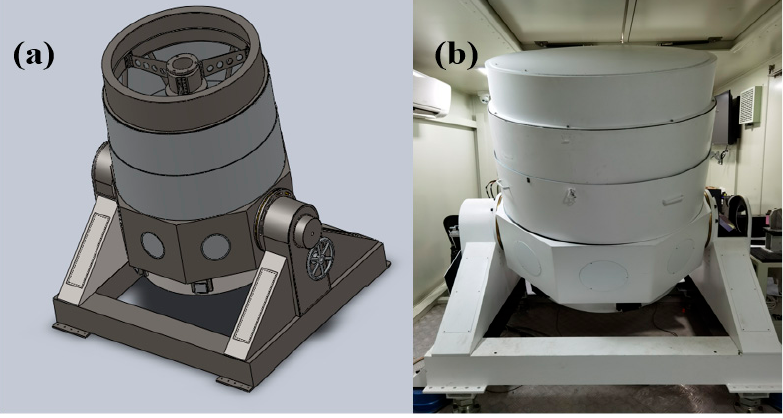
Figure 13. The structural of the upgraded 800 mm Cassegrain telescope. ( a ) Design diagram ( b ) Solid diagram.